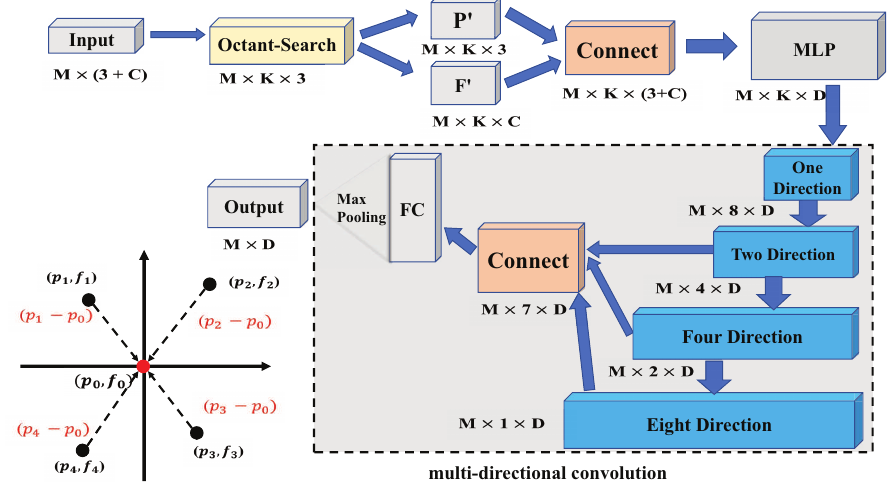
Figure 1. Illustration of the proposed directional spatial aggregation